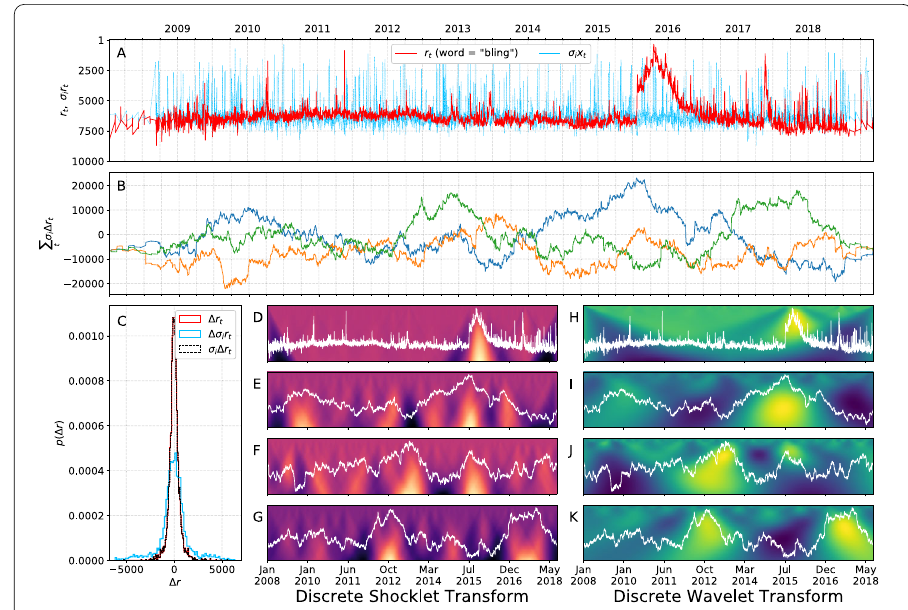
Figure 14 Intricate dynamics of sociotechnical time series. Sociotechnical time series can display intricate dynamics and extended periods of anomalous behavior. The red curve shows the time series of the ranks down from top of the word “bling” on Twitter. Until 2015/10/31, the time series presents as random fluctuation about a steady trend that is nearly indistinguishable from zero. However, the series then displays a large fluctuation, increases rapidly, and then decays slowly after a sharp peak. The underlying mechanism for these dynamics was the release of a popular song titled “Hotline Bling” by a musician known as “Drake”. Returns (cid:6) r t = r t +1 – r t are calculated and their histogram is displayed in panel ( C ). To demonstrate the qualitative difference of the “bling” time series from other time series with an identical returns distribution, elements of the symmetric group σ i ∈ S T are applied to the returns of the original series, (cid:6) r t (cid:21)→ (cid:6) r σ it , and (cid:4) (cid:6) r σ it . The bottom-left panel ( C ) displays the resultant noise is integrated and plotted as r σ it = t (cid:9)≤ t time-decoupled probability distributions of the returns of the plotted time series. The distributions of (cid:6) r i and σ(cid:6) r i are identical, as they should be, but the integrated series have entirely different spectral behavior and dynamic ranges. Panels ( D )–( G ) display the discrete shocklet transform of the original series and the random (cid:4) (cid:6) r σ it , showing the responsiveness of the DST to nonstationary local dynamics and its insensitivity walks t (cid:9)≤ t to dynamic range. The right-most column of panels ( H )–( K ) displays the discrete wavelet transform of